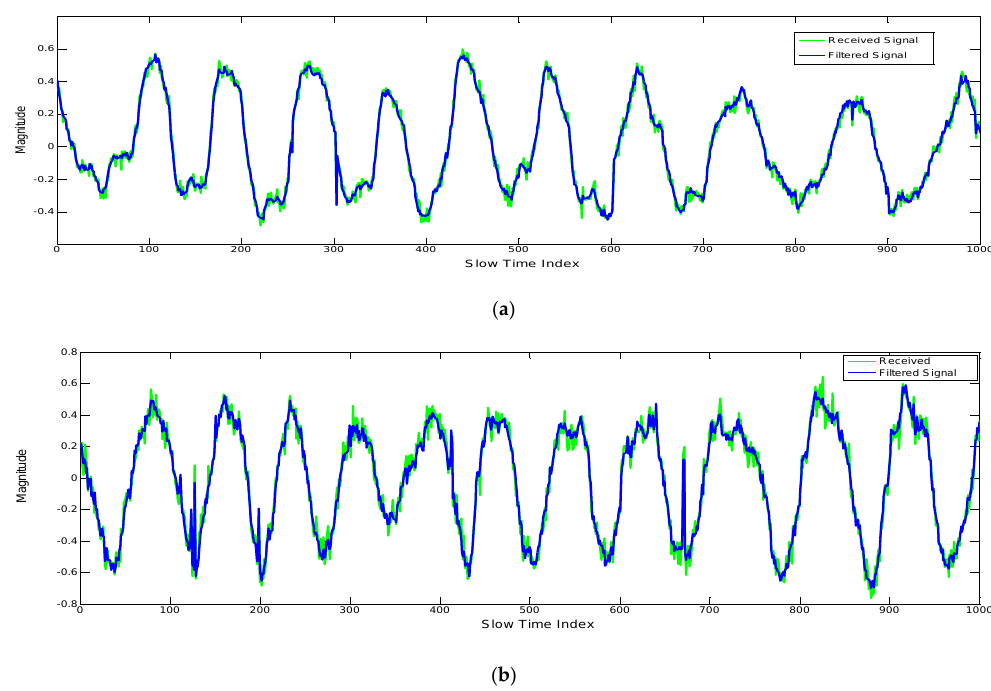
Figure 9. Vital signal obtained before and after Kalman filter (KF) at different locations: ( a ) at a distance of one meter from the radar, and ( b ) at a distance of two meters.